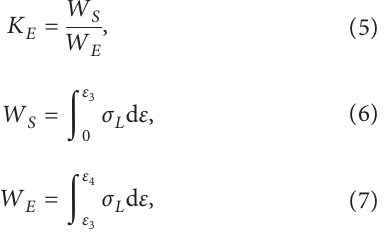
ET and gas pressure.